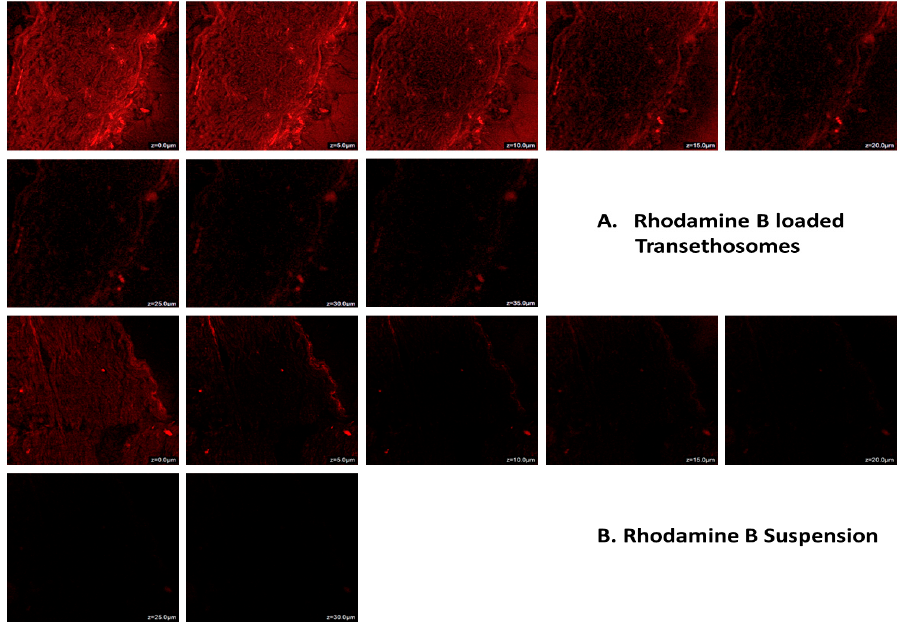
Figure 7. CLSM images of rat skin treated with ( A ) rhodamine B-loaded transethosomes and ( B ) rhodamine B-loaded hydroalcoholic suspension.